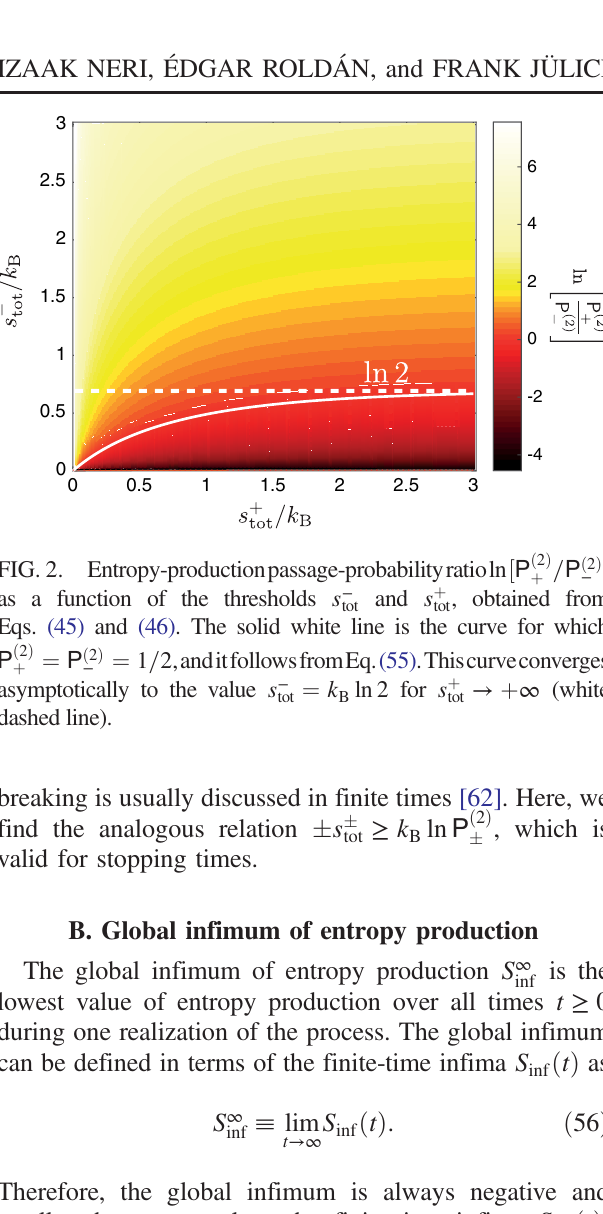
FIG. 2. Entropy-productionpassage-probabilityratioln ½ P ð as a function of the thresholds s − Eqs. (45) and (46). The solid white line is the curve for which P ð 2 Þ ¼ P ð 2 Þ − ¼ 1 = 2 ,anditfollowsfromEq.(55).Thiscurveconverges þ asymptotically to the value s − dashed